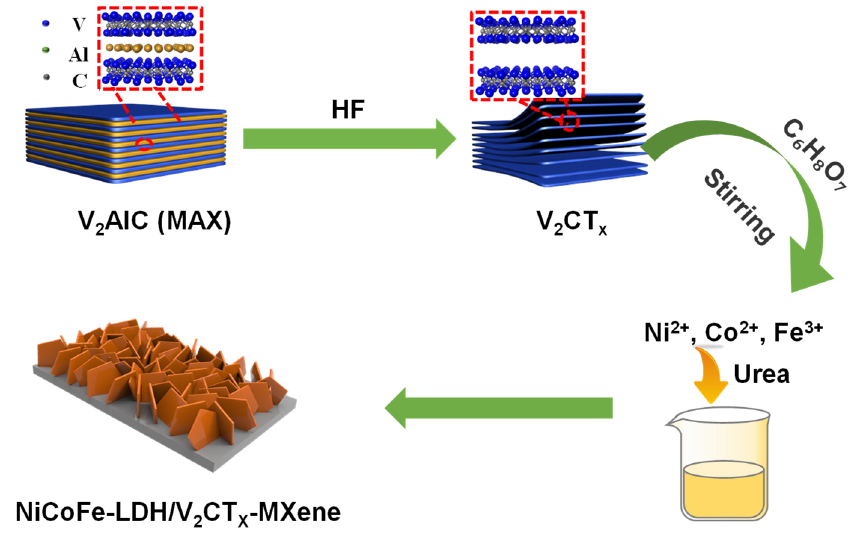
Figure 1. Schematic illustrating the preparation of NiCoFe–LDH/V 2 CT x –MXene.